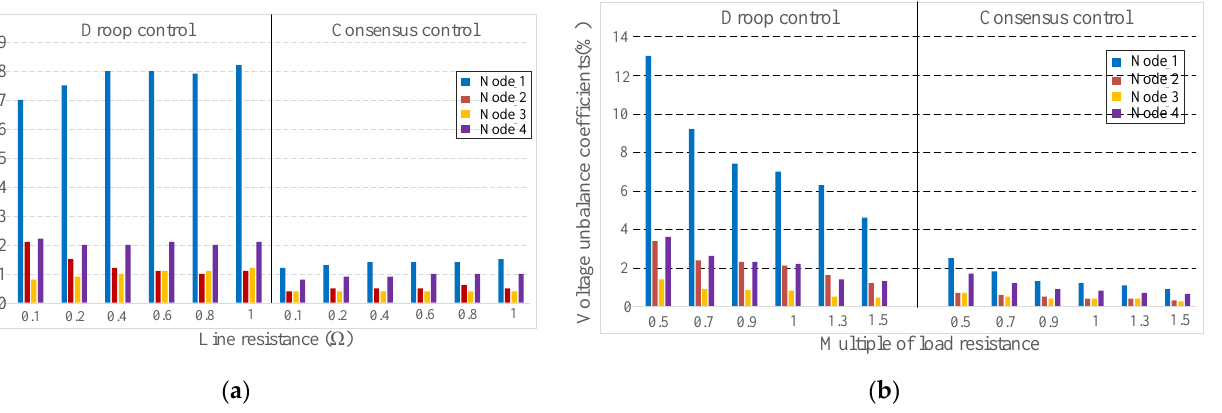
Figure 16. Variation of multi-node voltage unbalance coefficient with ( a ) line resistance and ( b ) load resistance under droop control and consensus control.